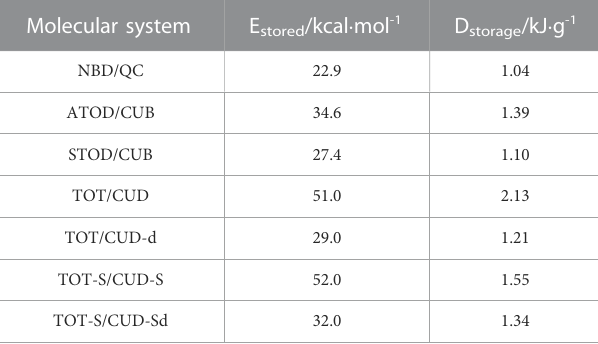
TABLE 1 Storage energy (E stored ) and storage density (D storage ) for different molecular compounds evaluated in this study as potential MOST